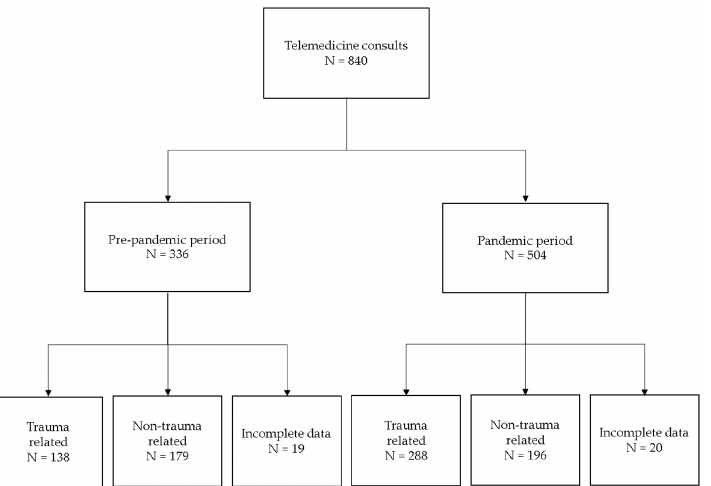
Figure 1. Study workflow. A retrospective chart review of telemedicine consults was performed at University Hospital Center Osijek for a total of 730 days. Consults were chronologically grouped as pre-pandemic or pandemic, as described in Materials and Methods. Depending on the etiology, consults were characterized as trauma- or non-trauma-related. Consults with unclear etiology or incomplete data were excluded from further analyses.